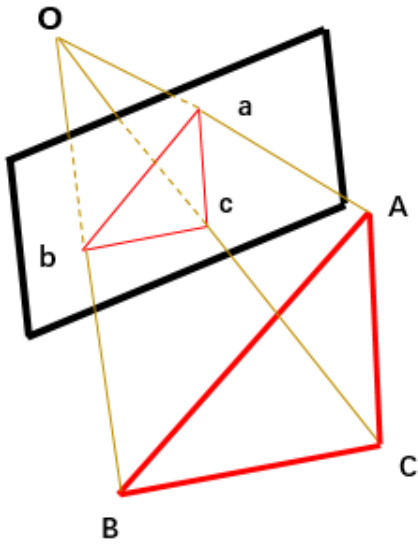
Figure 4. P3P schematic diagram.